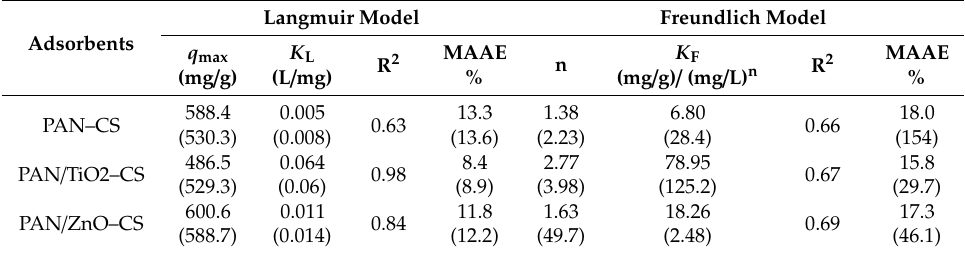
Figure 11. Isotherm models of ( a ) Langmuir and ( b ) Freundlich for cadmium ion adsorption using the bilayer nanofibers. Table 3. Parameters of Langmuir and Freundlich isotherms for the adsorption of cadmium by the bilayer nanofiber mats. The values between the parentheses represent the results obtained by the nonlinear optimization